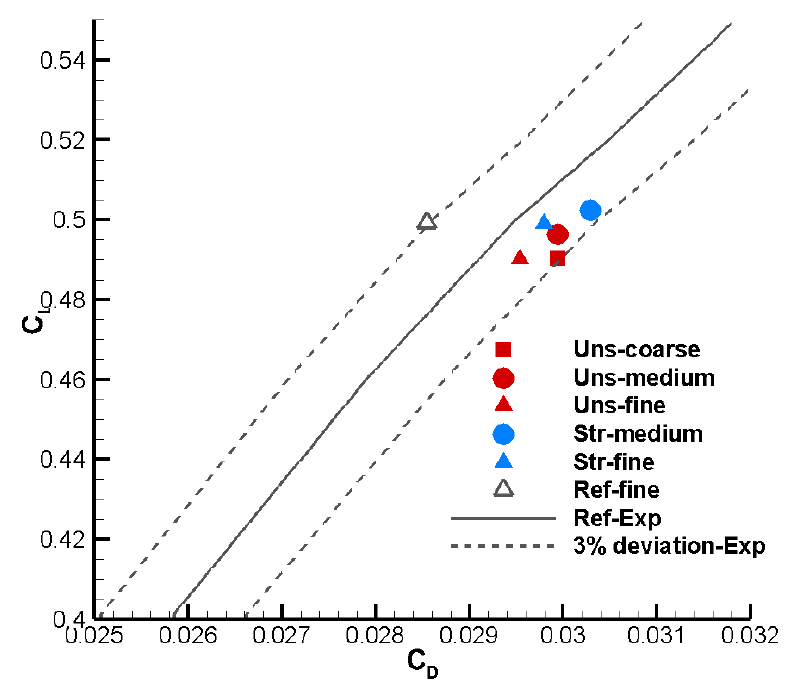
Figure 9. Coefficients of lift and drag for the wing body configuration.